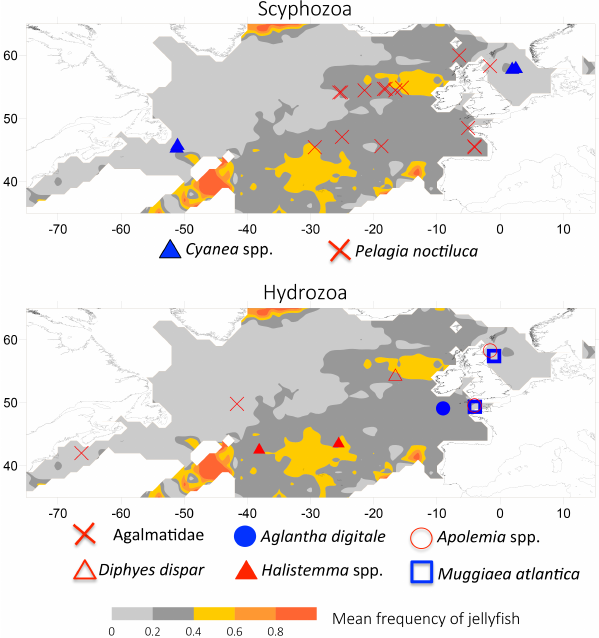
Figure 7. Jellyfish blooming species identified by genetic analysis from jellyfish material collected in CPR samples. The mean fre- quency of jellyfish presence recorded in 2000–2009 is also